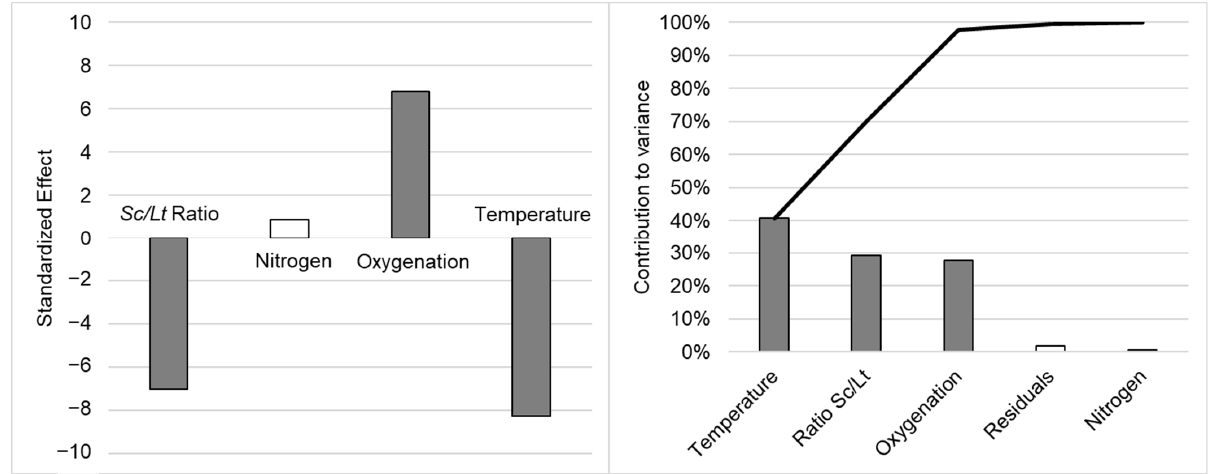
Figure 1. Impact of fermentation parameters on the AUC Lt /AUC Sc ratio: standardized effect ( left ) and Pareto chart of contributions to variance ( right ). Data are noted as statistically not significant ( p -value > 0.1, white) or very significant ( p -value < 0.01, dark grey). The black curve on the Pareto chart is the cumulated contribution to variance.